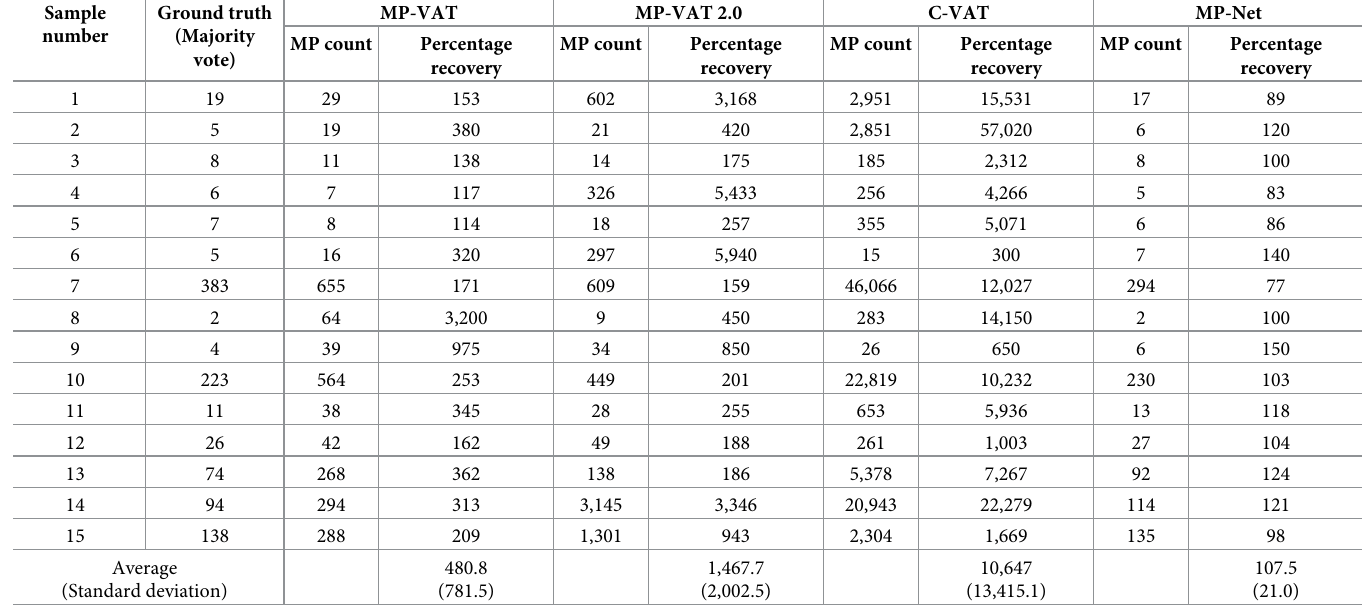
Table 6. MP count and percentage recovery obtained for 15 clam MP images. The MP quantity predicted by MP-Net was much closer to the ground truth compared to MP-VAT, MP-VAT 2.0, and C-VAT. Sample Ground truth number (Majority